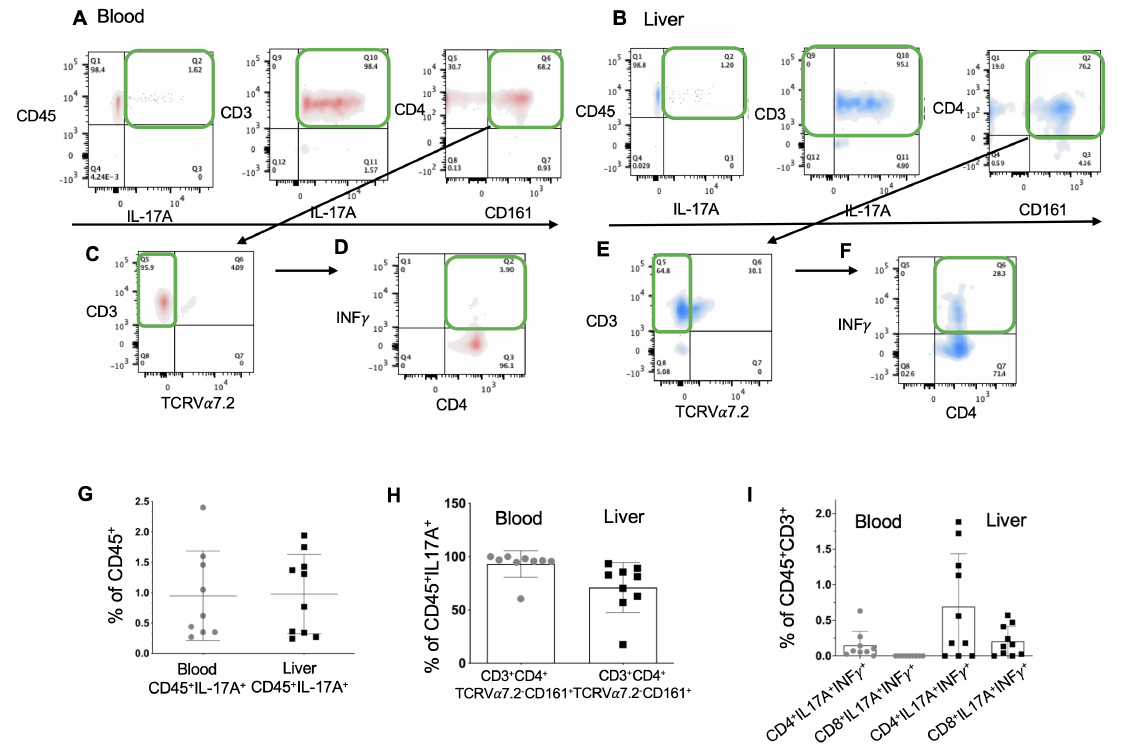
Figure 3. Th17 and MAIT cells are the two main sources of IL-17A in the liver. Representative plots of lymphoid IL-17A expression in patients’ ( A ) blood and ( B ) liver immune cells. Lym- phoid IL-17A expression, especially by Th17 (CD45 + CD3 + CD4 + CD161 + TCRValpha7.2 − ) and MAIT (CD45 + CD3 + CD161 + TCRValpha7.2 + ) cells, in ( C ) blood and ( E ) liver immune cells. Percentage of INF γ + cells among Th17 IL-17A + cells in the ( D ) blood and ( F ) liver immune cells. ( G ) The percentage of the lymphoid population secreting IL-17A in blood and liver. ( H ) The percentage of IL- 17A + cells secreted by CD45 + CD3 + CD4 + TCRVapha7.2 − (Th17, Th1) cells in blood and liver samples. ( I ) Percentage of IL-17A + INF γ + double-positive cells among Th17 cells of both CD4 + and CD8 + groups. Presence of CD8 + IL-17A + INF γ + Tc17 cells only in the liver samples (FIBROTHER study). 2.5. The Human Liver Is Infiltrated by MAITs and T γδ